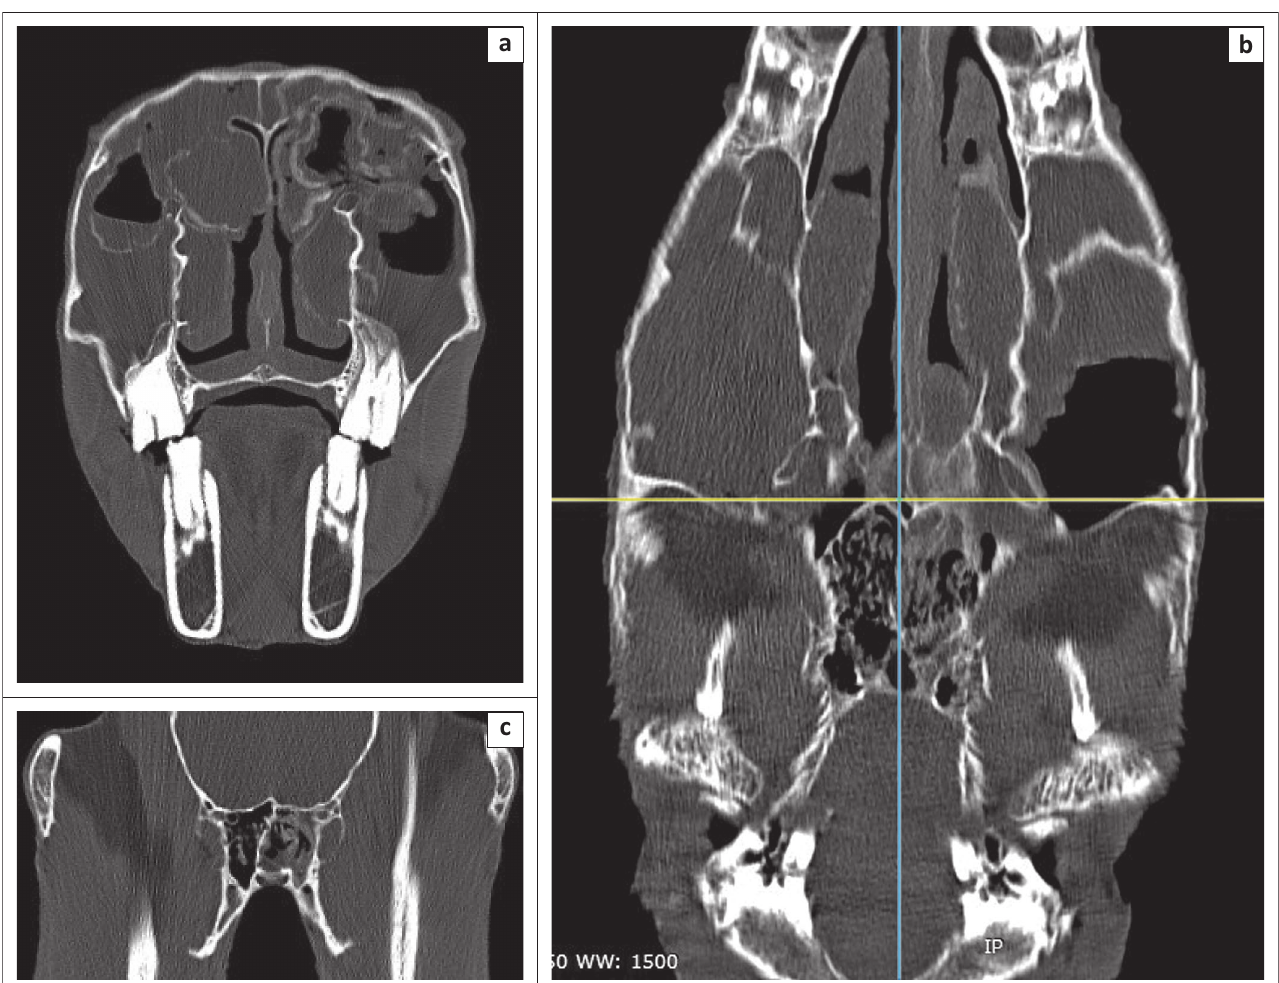
Source : Equine Clinic, University of Pretoria. FIGURE 2: Computed tomography study of the affected horse’s head. (a) Transverse image at the level of teeth 110 and 210. (b) Frontal image, parallel to the dorsal surface of the frontal bones, at the level of the ventral orbit. (c) Transverse close-up view of the sphenoidal sinus. Note the extensive bilateral fluid accumulation in the rostral and caudal maxillary sinuses, ventral and dorsal conchal sinuses, left sphenopalatine and left ethmoidal sinuses, with some fluid accumulations contained in partially mineralised walls.